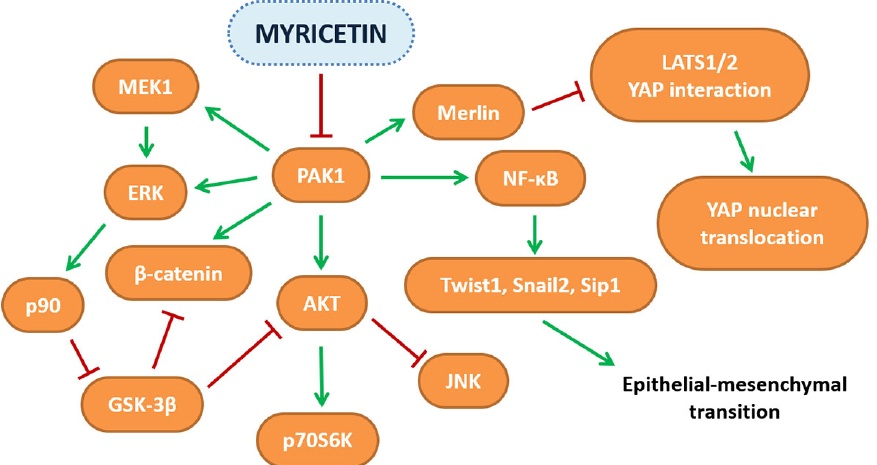
Figure 2. Schematic representation of the pathways affected by myricetin in several in vitro and in vivo cancer models.